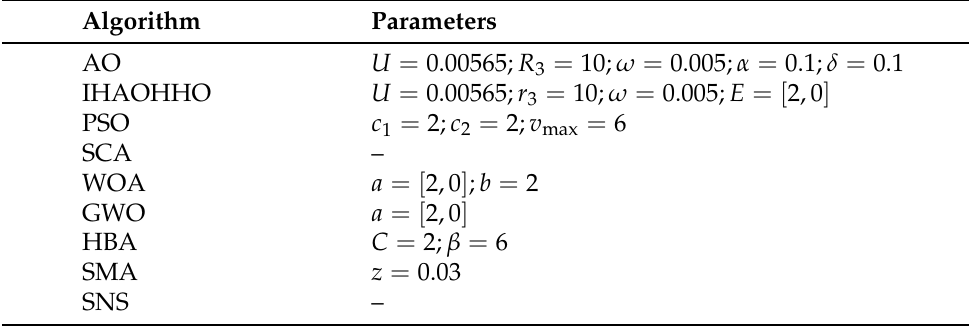
Table 9. Parameters for the compared